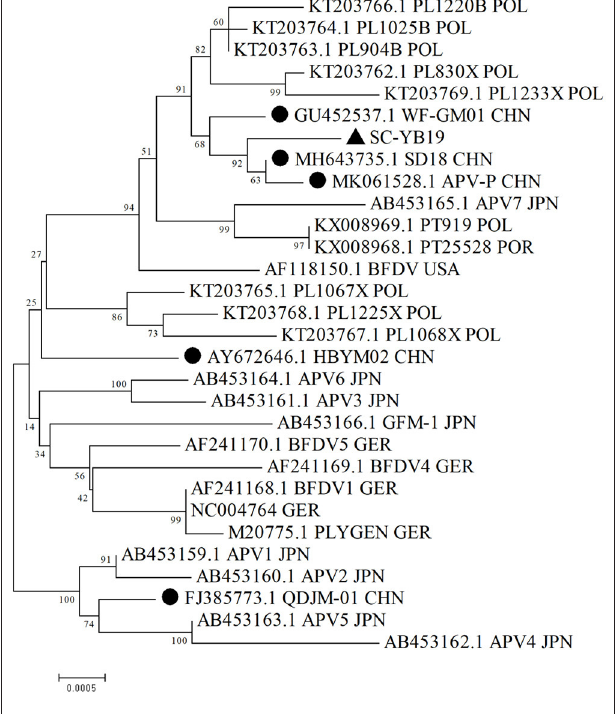
FIGURE 1 | Phylogenetic analysis of complete SC-YB19 sequence and related whole-genome strains from GenBank. Neighbor-joining was used to construct a phylogenetic tree, with bootstrap values of 1,000 replicates shown on branches. Scale bar represents p -distance. • presents the domestic strains. N presents the strains isolated in this study. CHN, China; GER, Germany; POL, Poland; POR, Portugal; USA, United States Of Amrica; JPN,